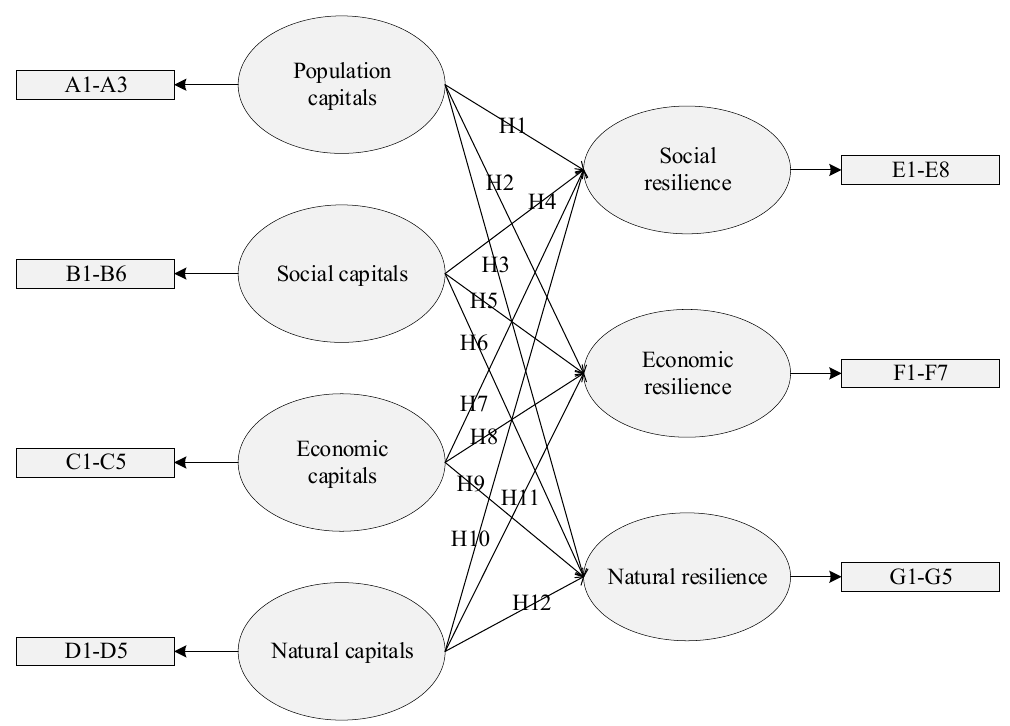
Figure 5. Model of waterlogging-resilience mechanism of urban community in China.